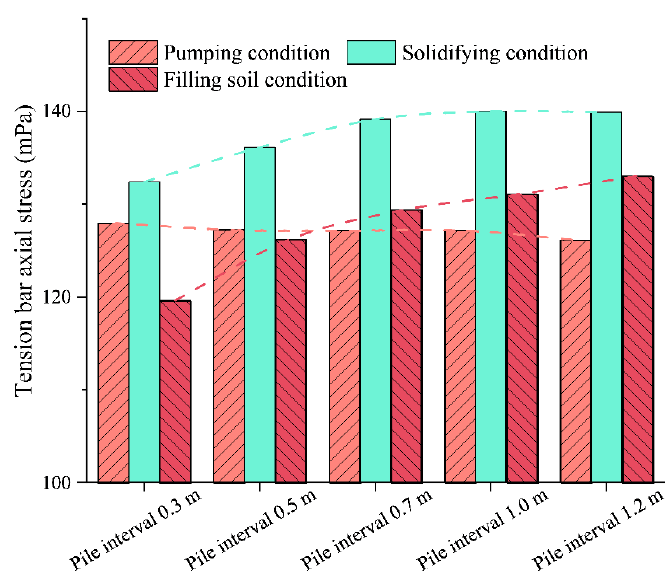
Figure 22. Pile bending moment of wood pile interval conditions.